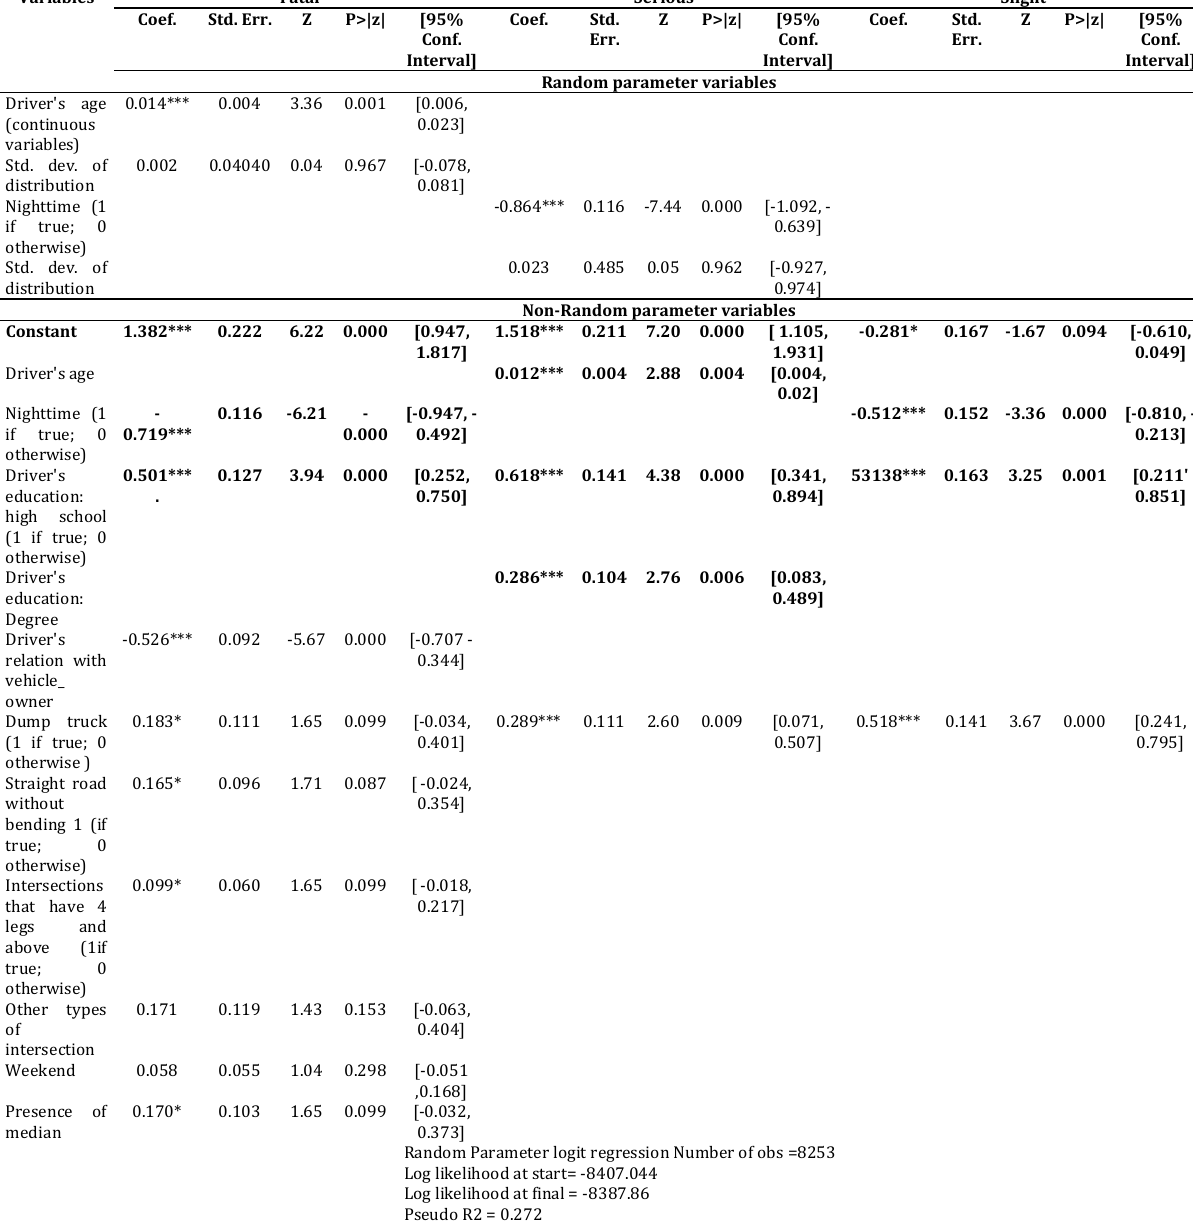
Table 4: Random parameter logit model